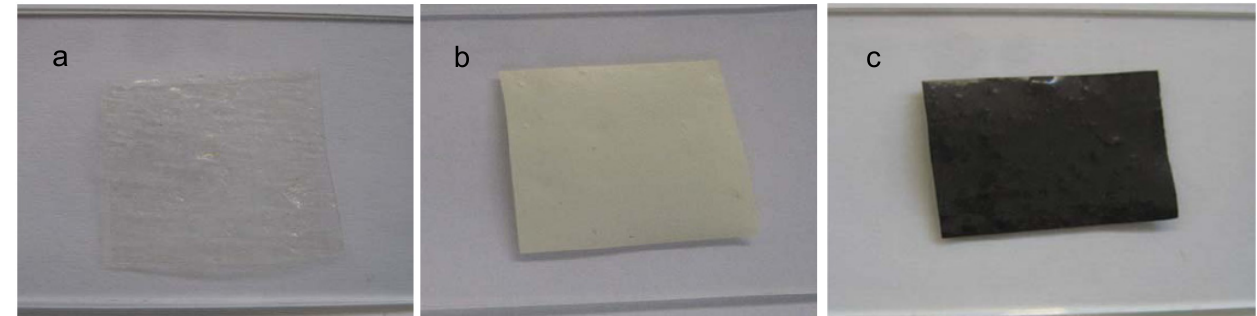
Figure 1. Optical images of typical films prepared by evaporative casting of ( a ) chitosan solution; ( b ) chitosan-TiO dispersion; and ( c ) chitosan-Ag dispersion. Dimensions of 2 films are 2.0 cm × 2.0 cm ((a) and (b)) and 3.0 cm × 2.0 cm (c). All films were prepared using chitosan batch CHM1.